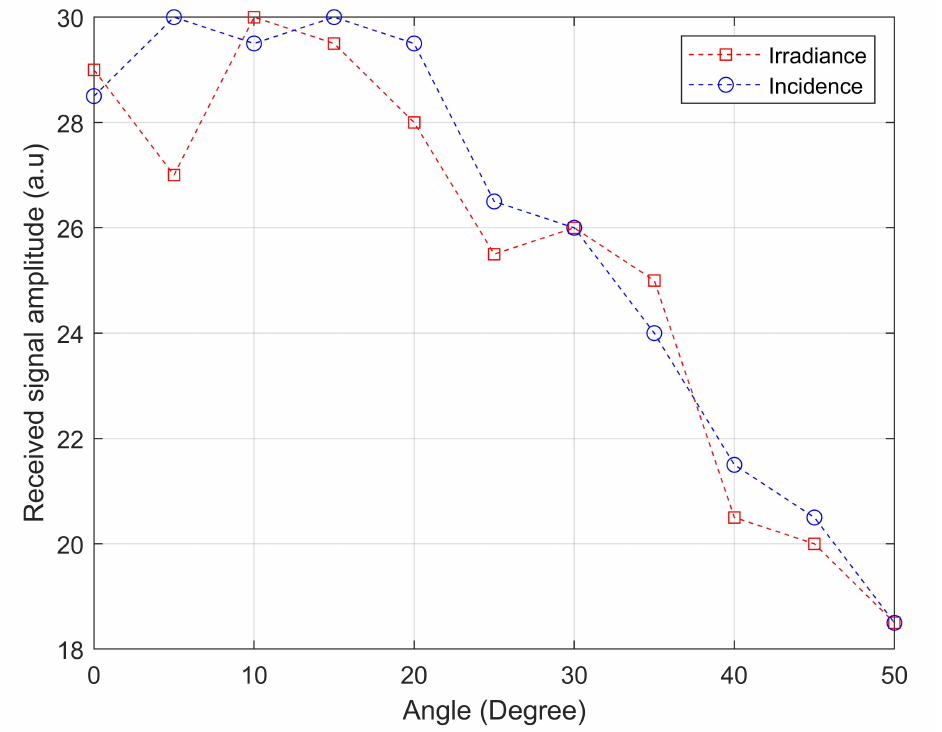
Figure 19. Angle effects on the received signal